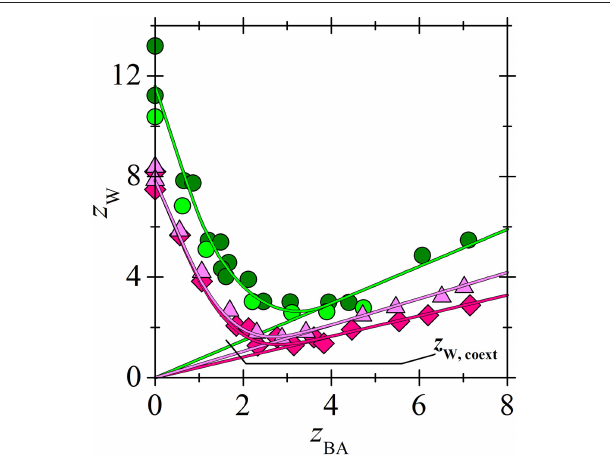
FIGURE 8 | Concentration dependences of acids distribution coefficients in two-phase systems (water + IL) for BA extracted by FIGURE 10 | Comparison of water loading of IL for phosphonium (Marták and Schlosser, 2016 ) and ammonium (Blahušiak et al., 2013) ILs vs. BA loading of IL for the selected systems in Figure 7 . Composition of dry solvent phase (wt. % of IL in dodecane): [C n C n C n C 1 N + ][BTMPP − ] 70 ( ), undiluted ( ),